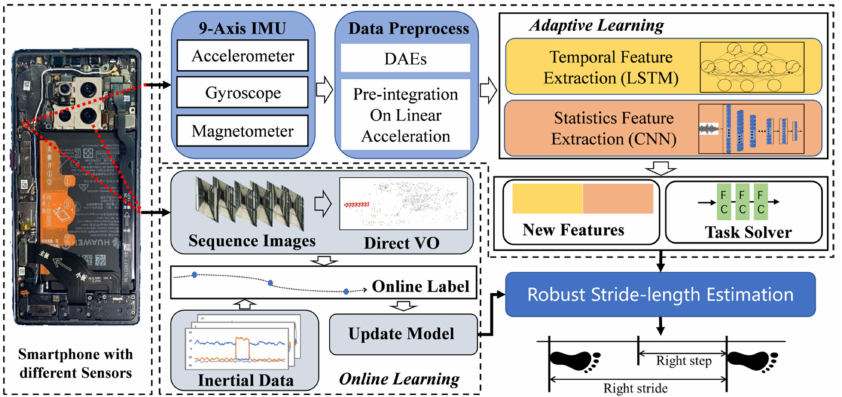
Figure 1. Flowchart of the efficient learning-based stride-length estimation.